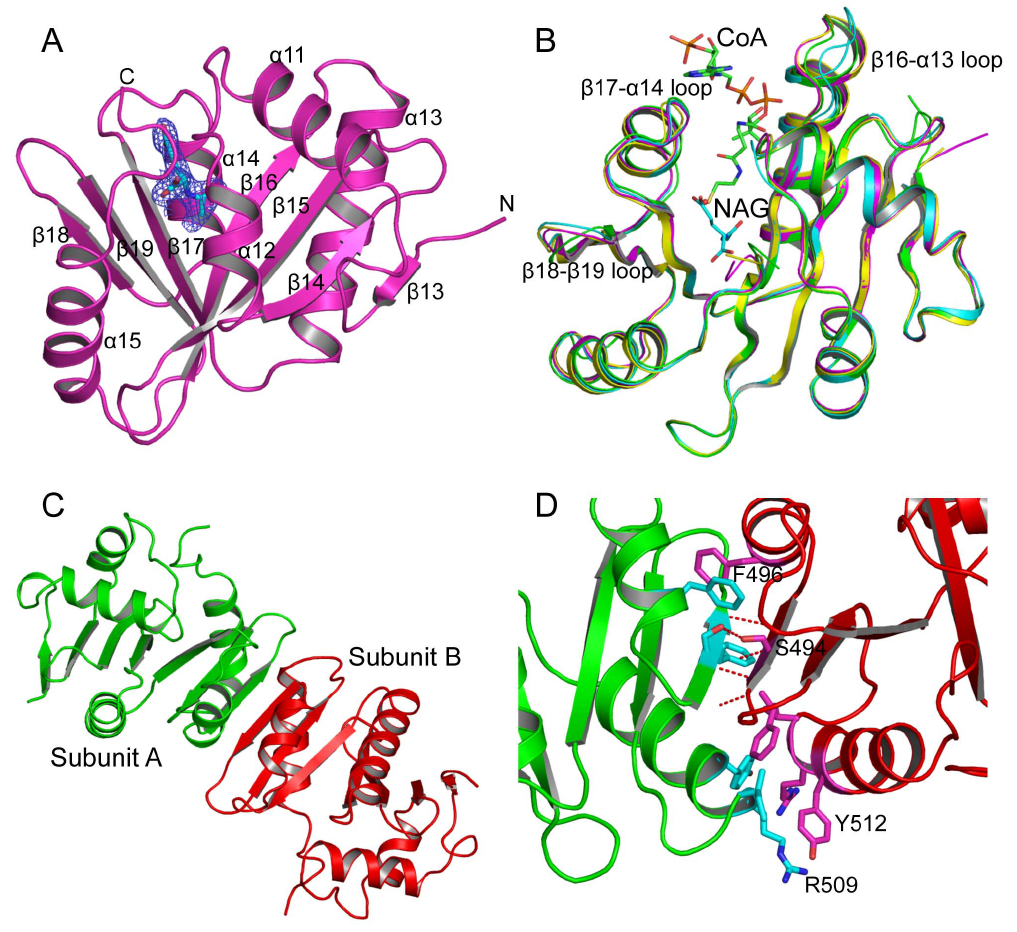
Figure 3. Structure of hNAT. A: Ribbon diagram of hNAT subunit structure. Bound NAG is shown as sky-blue sticks. The electron density map (2F o –F c ) around bound NAG (contoured at 1.0 s ) is shown as blue cage. B: Superimposition of four hNAT subunits in asymmetric unit. The bound NAG is shown as sky-blue sticks. The proposed bound CoA is shown as green sticks. Subunits A, B, X and Y are shown in pink, yellow, green and blue ribbons, respectively. C: The hNAT molecular dimer. Subunits A and B are shown in green and red ribbons, respectively. D: Details of the interactions between subunits A and B. Side-chains of the residues in the interface are shown in sticks. Potential hydrogen bonding interactions are shown in red dashed lines.